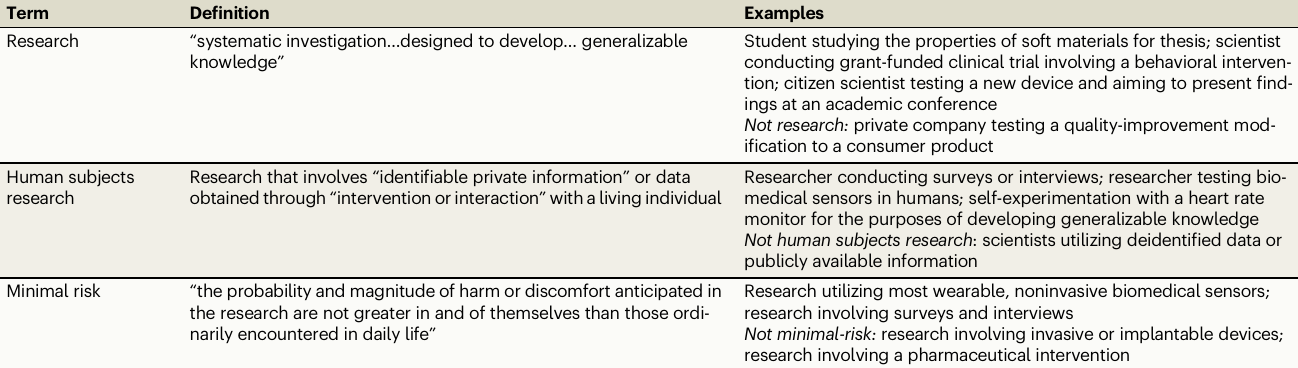
Table 1 | Minimal-risk research with human subjects: de fi nitions from the U.S. Common Rule 16 and examples Term De fi